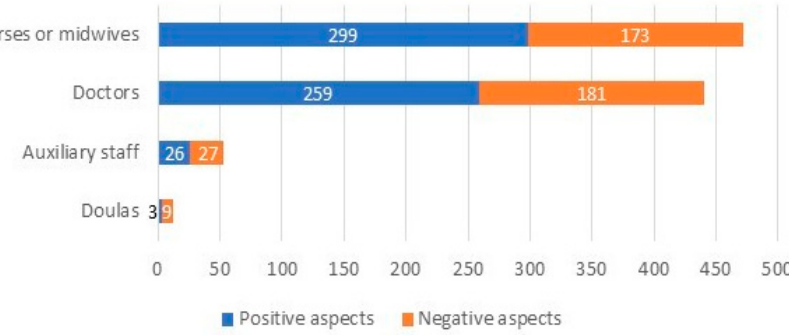
Figure 3. Professionals as part of the positive or negative aspects of childbirth.